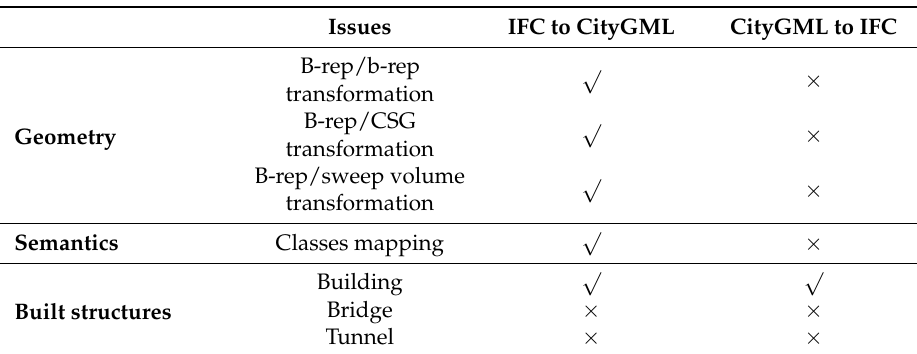
Table 2. Key issues that need to be focused on during BIM/GIS